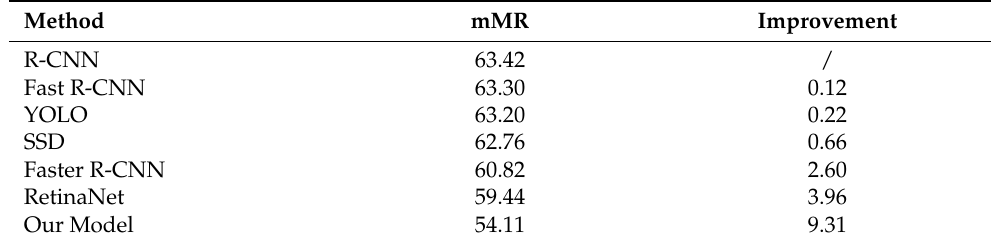
Table 2. Detection performance (Recall) of the seven tested methods using the LifeCLEF test set.